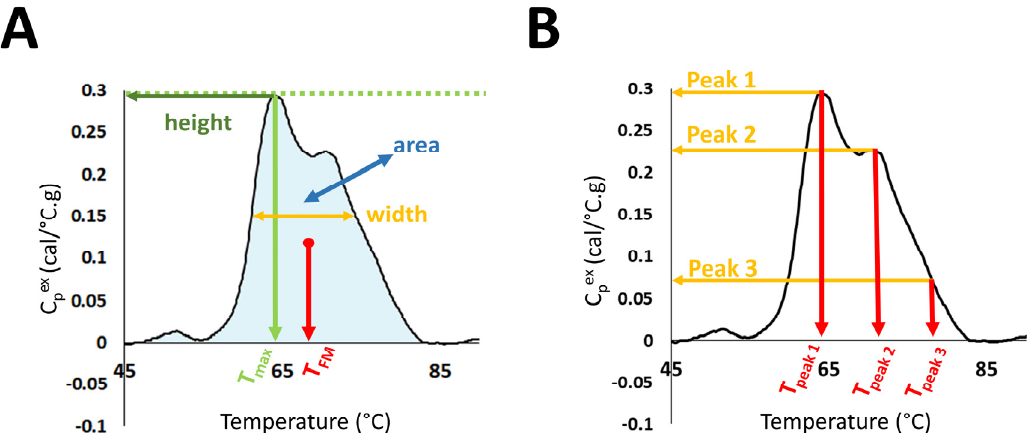
Figure 1. Selected DSC curve features evaluated in the study. ( A ) DSC curve peak width at half height; total area under the curve, maximum peak height; temperature of the peak maximum (T max ); and first moment temperature, T FM . ( B ) Maximum excess specific heat capacity (C pex ) and position of Peaks 1, 2, and 3. T FM was calculated using Equation (1).